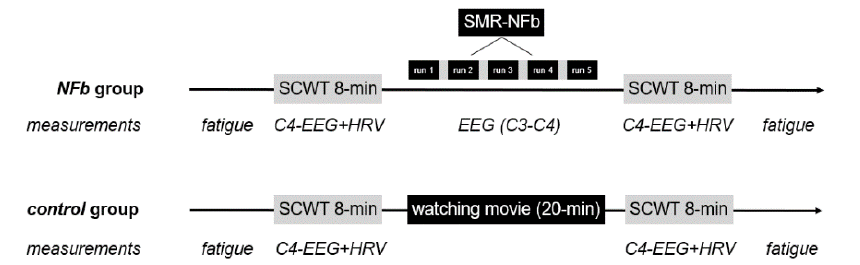
Figure 1. Procedure and measurements. SCWT, Stroop Color Word Test; SMR-NFb, neurofeedback training based on SMR frequency band. Fatigue was evaluated by an analog visual scale. HRV, Heart rate variability as collected by RR cardiac interbeat time series; EEG, electroencephalographic activities.